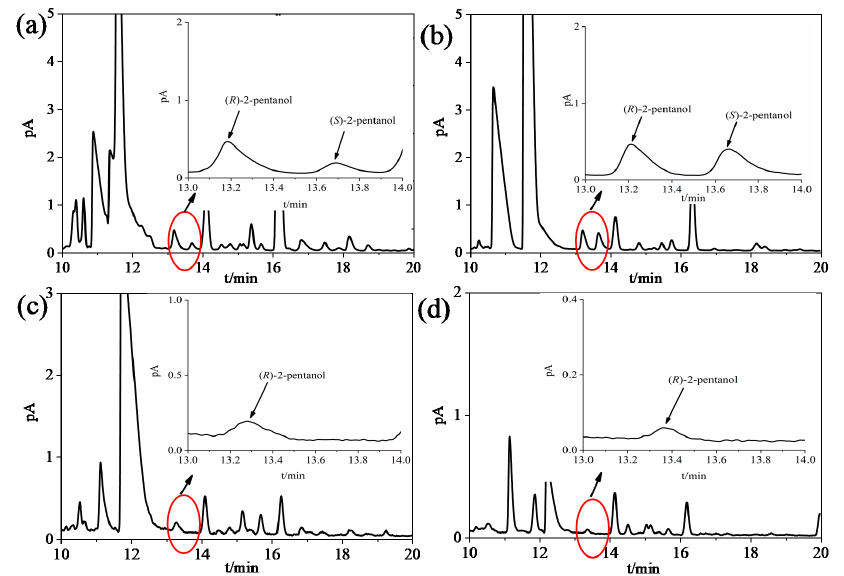
Figure 3. Enantiomeric separation chromatograms of 2-pentanol in representative Baijiu samples of different aroma types using LLE ( a ): SSB, ( b ): STB, ( c ): LTB, ( d ): RTB.